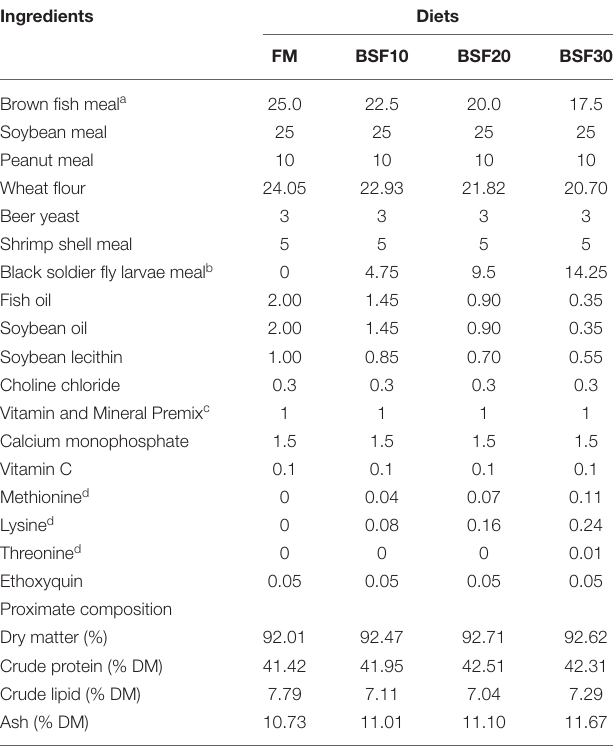
TABLE 1 | Formulation and proximate composition of experimental diets (% dry